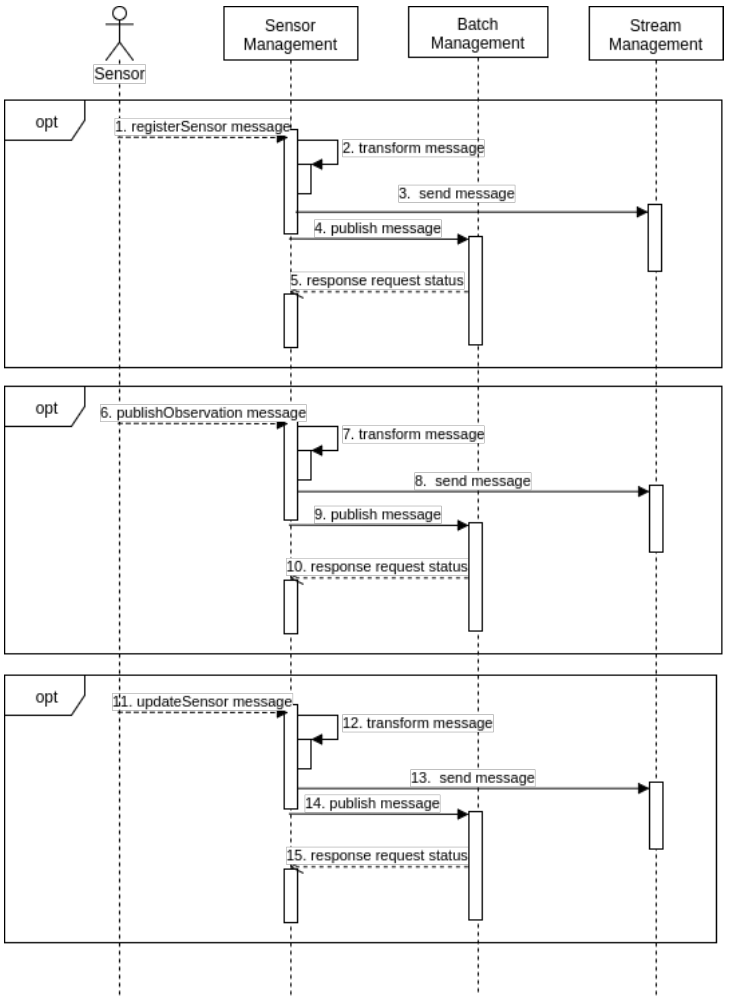
Figure 3. Interactions between Sensors, SM, BM and StrM arranged in time